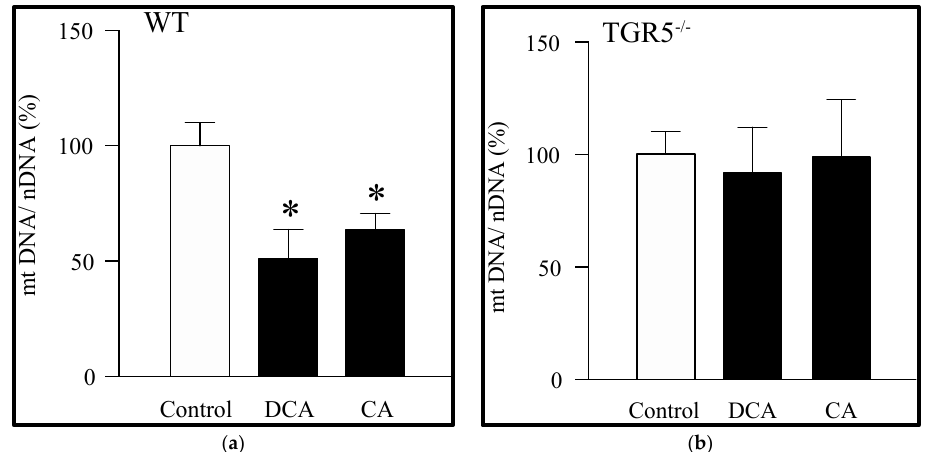
Figure 2. Deoxycholic acid (DCA) and cholic acid (CA) decrease the amount of mitochondrial DNA in muscle fibers through a TGR5-dependent mechanism. Extensor digitorum longus (EDL) muscle fibers from WT and TGR5 − / − mice were incubated with DCA or CA for 72 h, and mitochondrial DNA (mtDNA) and nuclear DNA (nDNA) were determined. ( a ) mtDNA detected in WT fibers incubated with DCA or CA. ( b ) mtDNA detected in TGR5 − / − fibers incubated with DCA or CA. Values correspond to the mean ± SEM. ( n = 3, * p < 0.05 vs. control condition; one-way ANOVA and Tukey’s multiple comparison test).